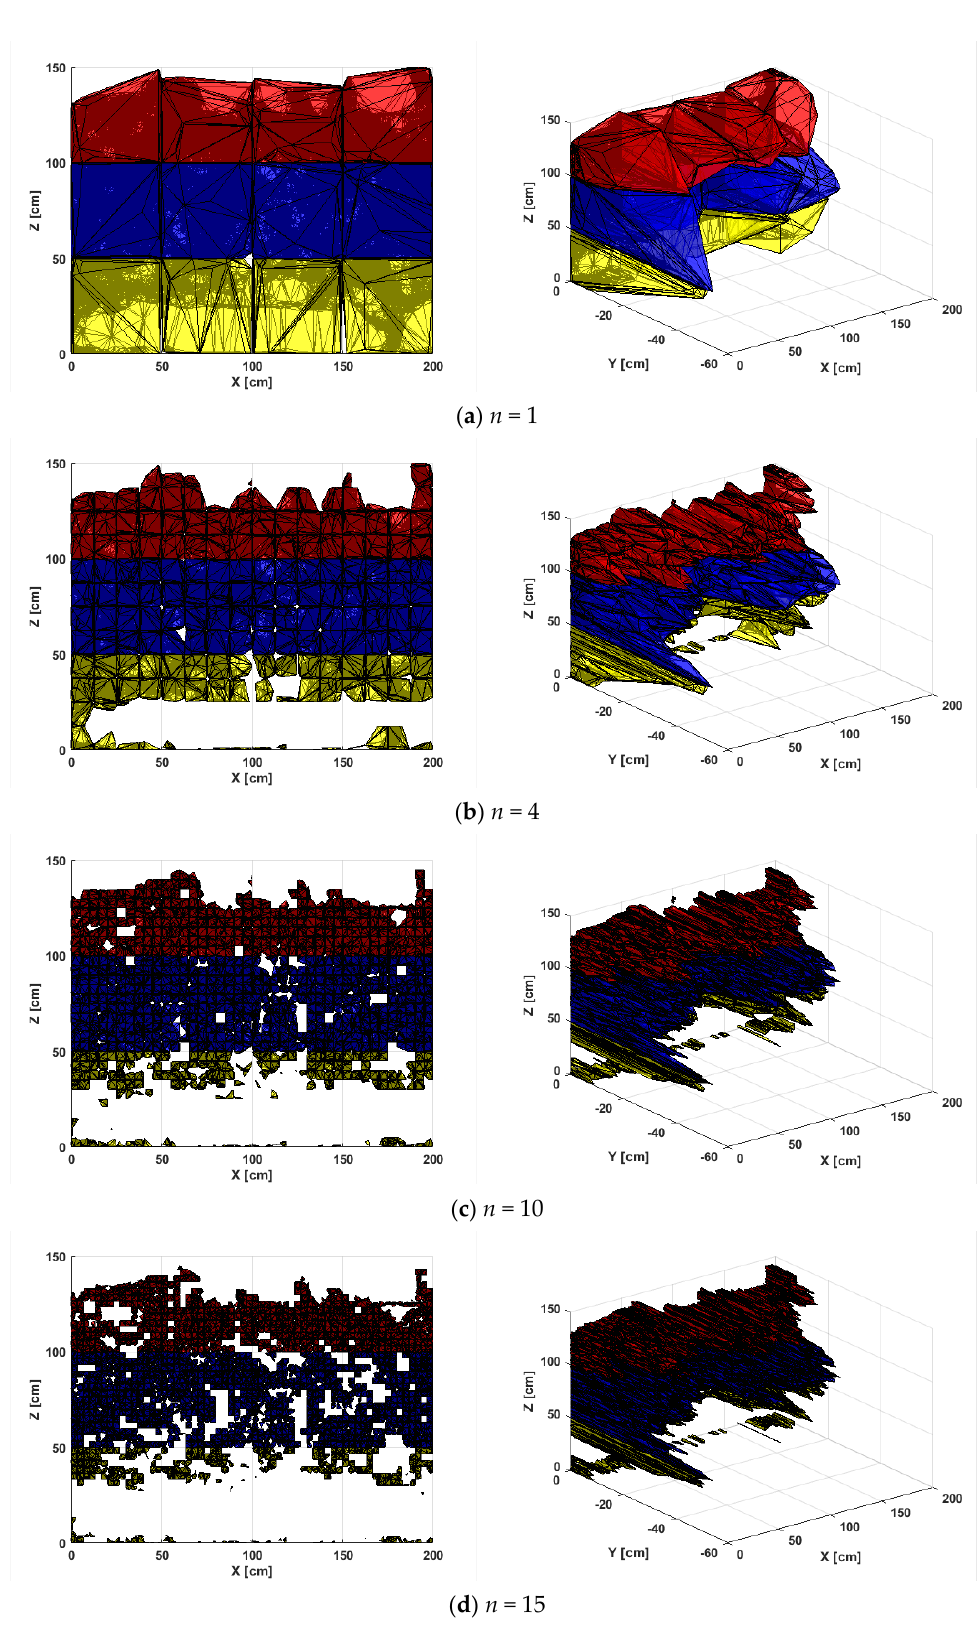
Figure 12. Photogrammetric side view of canopy volume and a 3D projection at different segment subdivisions ( n = 1 to n = 15) for the right half of the vine. Segments of the same height are shown in different